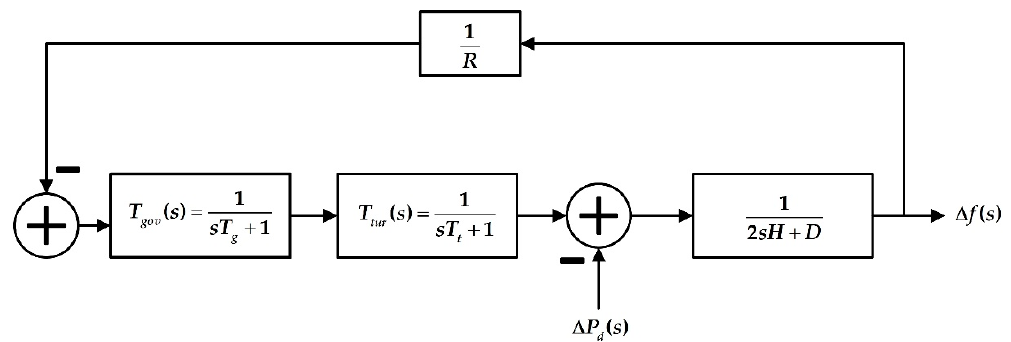
Figure 2. Block diagram of a power system with primary control only.